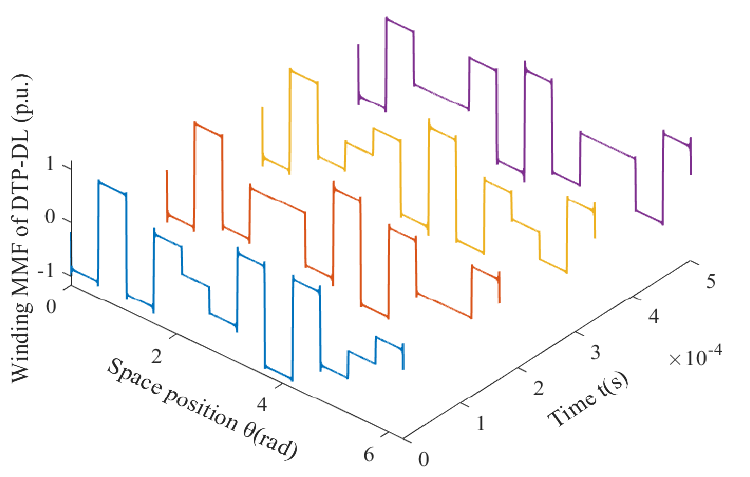
Figure 5. For 12-slot/10-pole DTP-DL winding, resultant winding MMF changes with time and space.